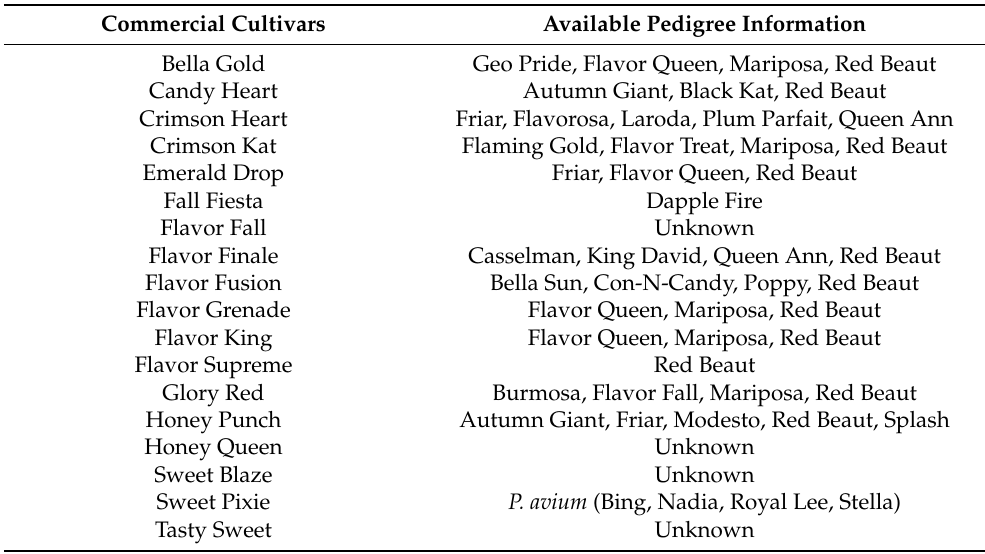
Table 5. Commercial cultivars of interspecific hybrids of Zaiger Genetics analyzed in this study and their available pedigree